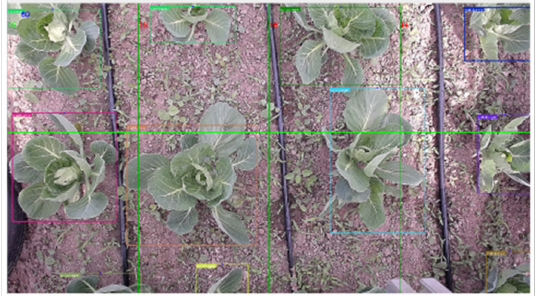
Figure 3. Schematic diagram of the field-of-view segmentation of